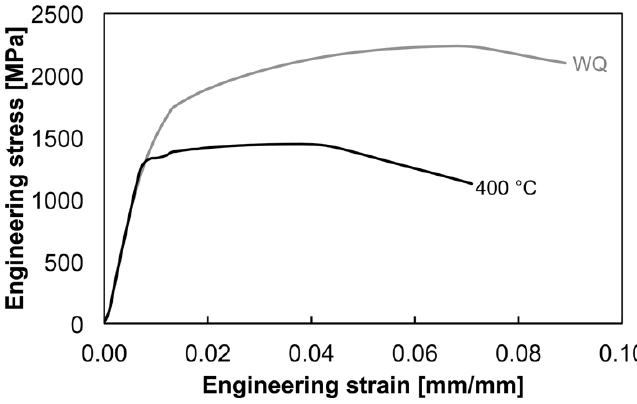
Figure 7. Engineering stress – strain curves for the water quenched (WQ) and 400 °C tempered samples.